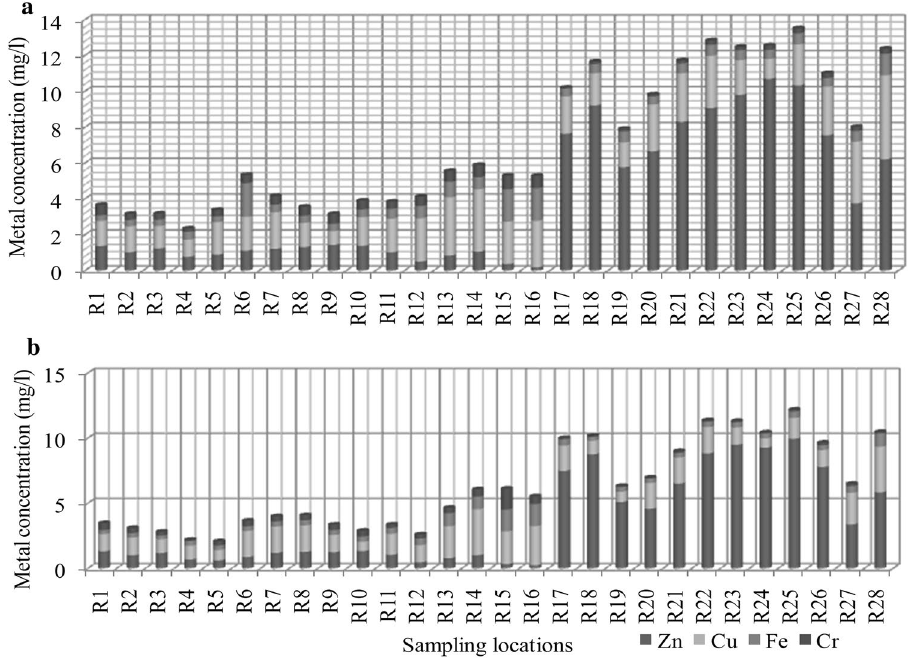
Fig. 3 Metal concentration during pre- ( a ) and post- ( b ) monsoon months at different sampling